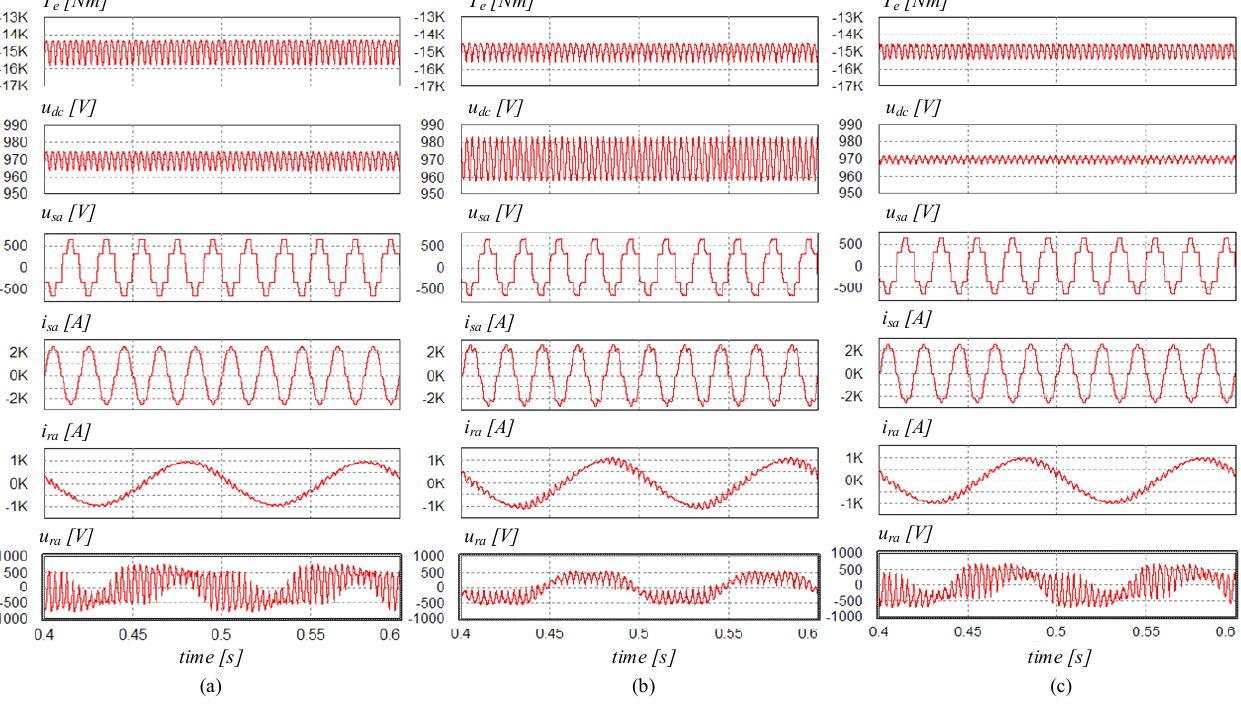
Figure 5. Simulation results of a 2 MW DFIG-DC system at 1200 rpm for field-oriented control FOC ( a ), direct torque and flux module control DT Ψ C ( b ), and the proposed direct torque and x variable control DTXC ( c ) with unlimited rotor voltage at the steady state.